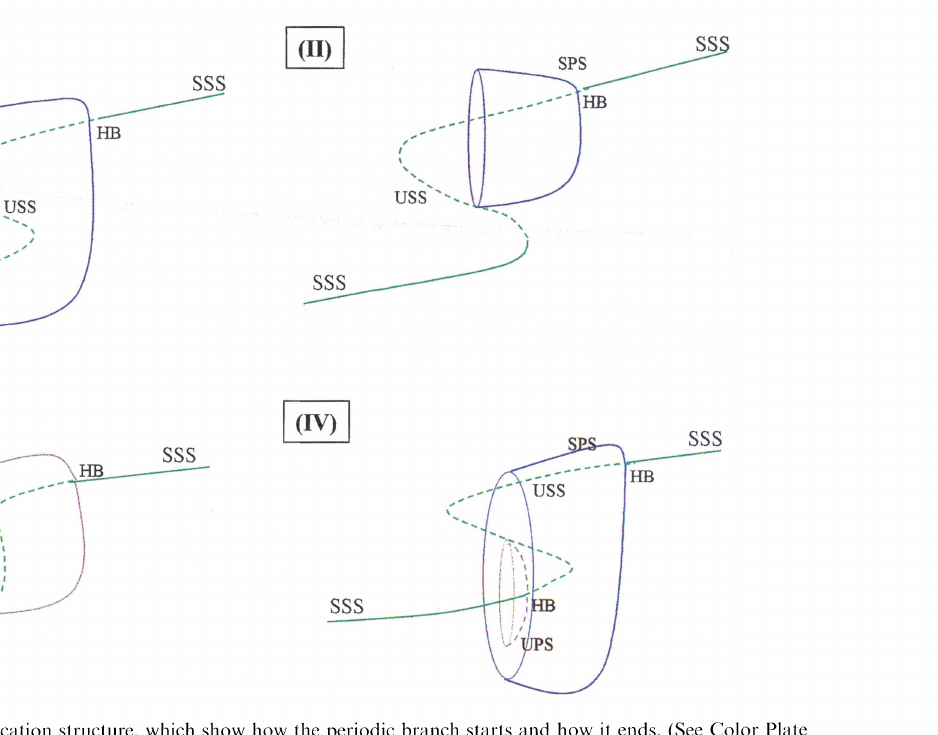
FIGURE 15 Four types of a bifurcation structure, which show how the periodic branch starts and how it ends. (See Color Plate